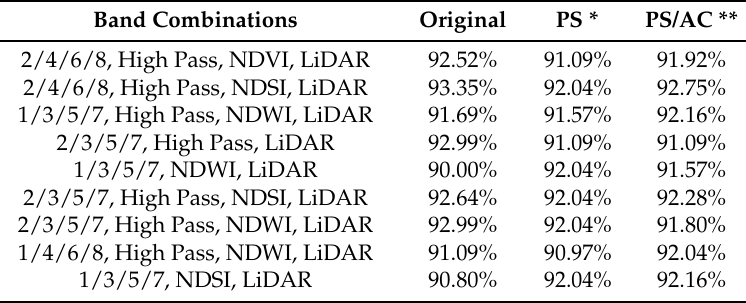
Table 2. Band combinations used for the habitat